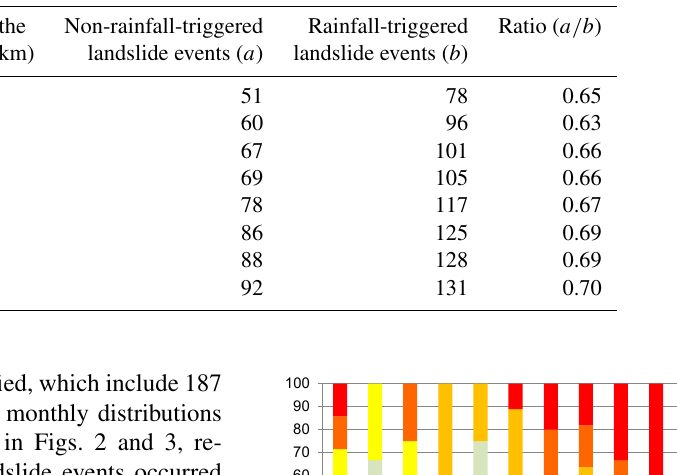
Table 2. Ratio of non-rainfall-triggered landslide events/rainfall-triggered landslide events for different buffer distance to the reference rain gauge.